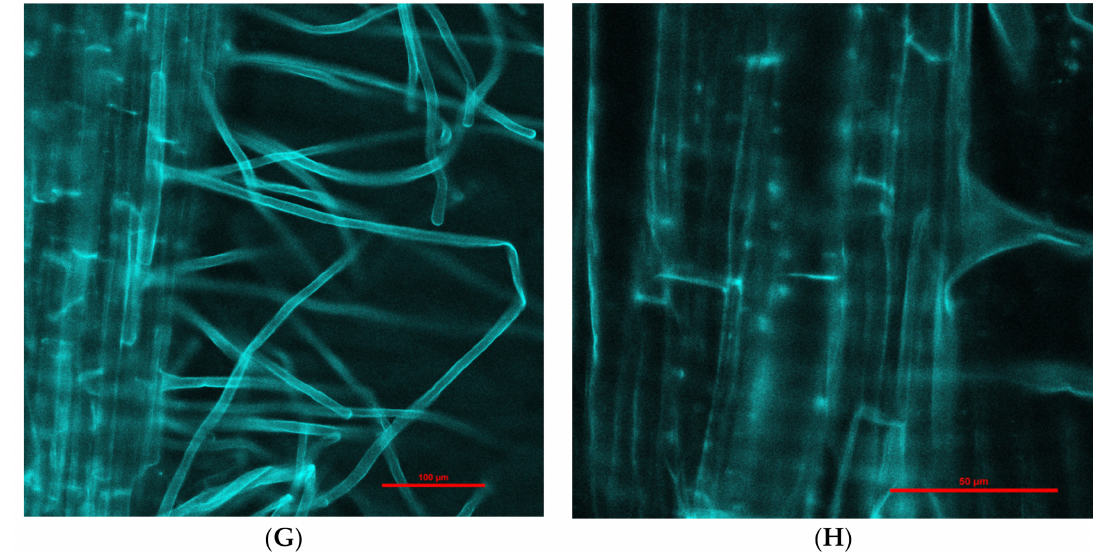
Figure 2. Examples of confocal laser scanning images of barley seedling leaves ( A , C , E , F ) and roots ( B , D , G , H ) treated hy- droponically with Fe 3 O 4 NPs. ( A )—control seedling leaves (magnification 200 × ); ( B )—control seedling root (magnification 200 × ); ( C )—presence of fluorescent Fe 3 O 4 NPs in seedling leaves after 1-day treatment (magnification 200 × ); ( D )—presence of fluorescent Fe 3 O 4 NPs in seedling roots after 1-day treatment (magnification 200 × ); ( E )—presence of fluorescent Fe 3 O 4 NPs in seedling leaves after 6-day treatment (magnification 200 × ); ( F )—presence of fluorescent Fe 3 O 4 NPs in seedling leaves after 6-day treatment (magnification 600 × ); ( G )—presence of fluorescent Fe 3 O 4 NPs in seedling roots after 6-day treatment (magnification 200 × ); ( H )—presence of fluorescent Fe 3 O 4 NPs aggregates (rows) in seedling roots after 6-day treatment (magnification 600 ×